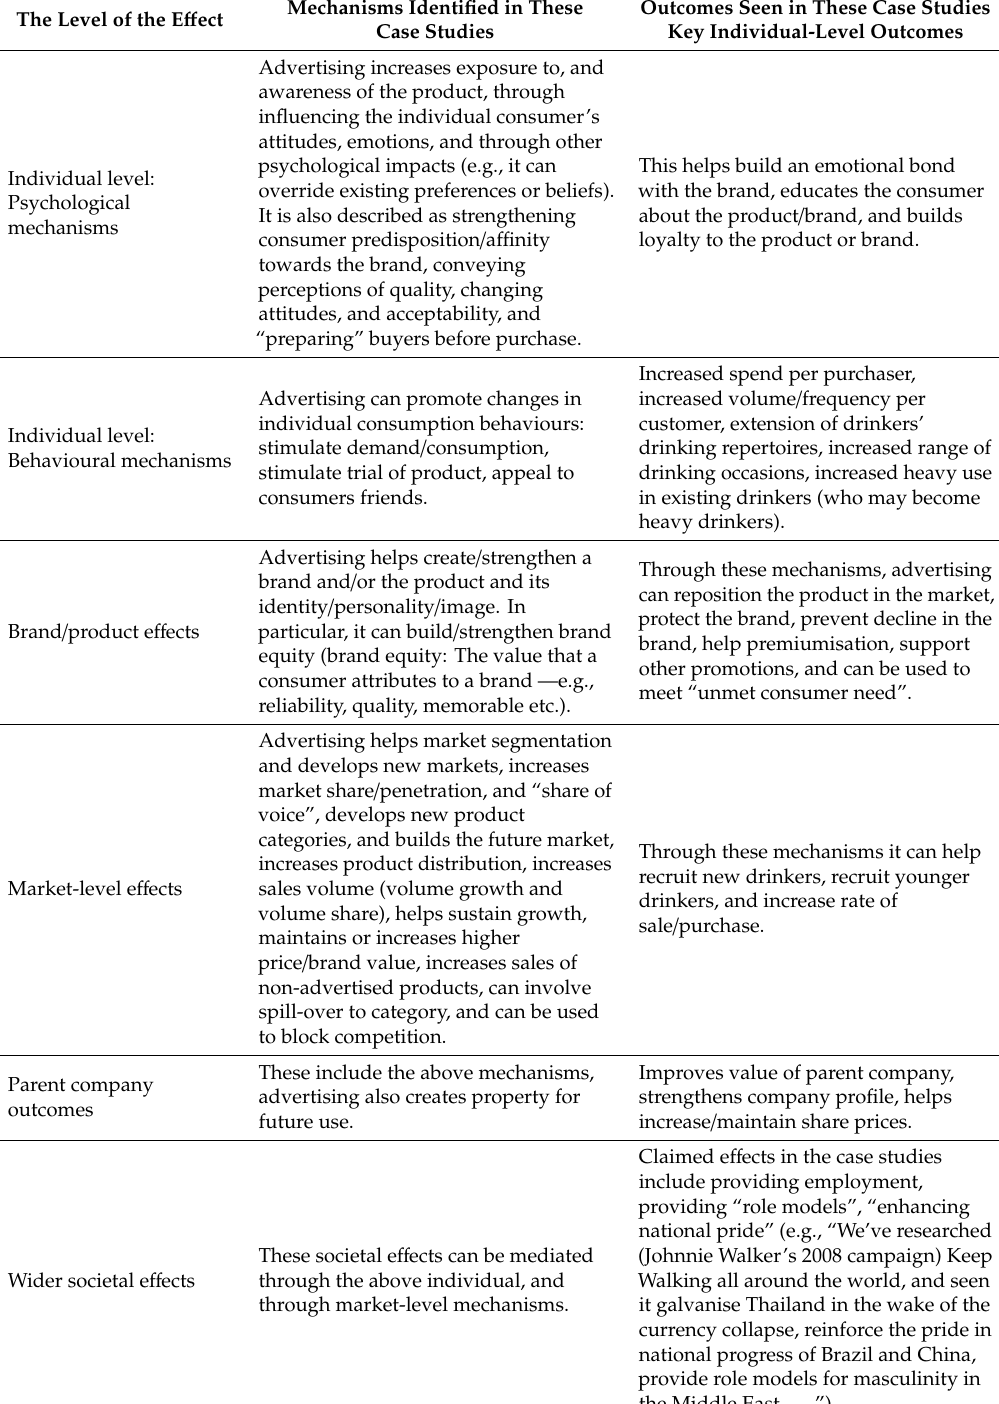
Table 3. Summary of advertising’s reported e ff ects and mechanisms of e ff ect, from the individual level to the system level (summarised from Supplementary File, Table